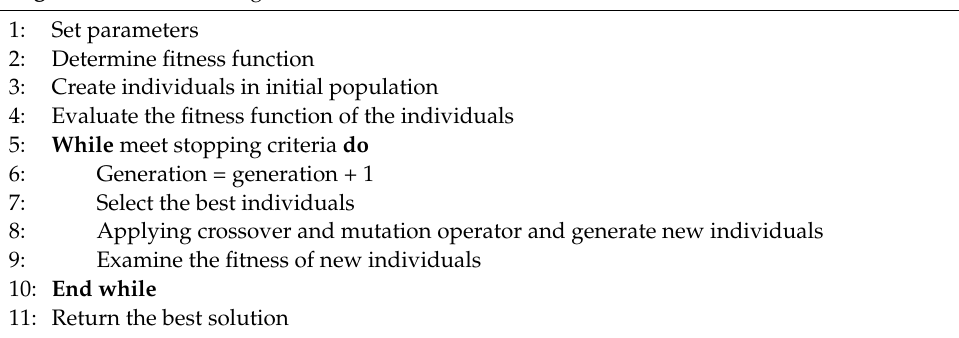
Algorithm 1. Genetic Algorithm